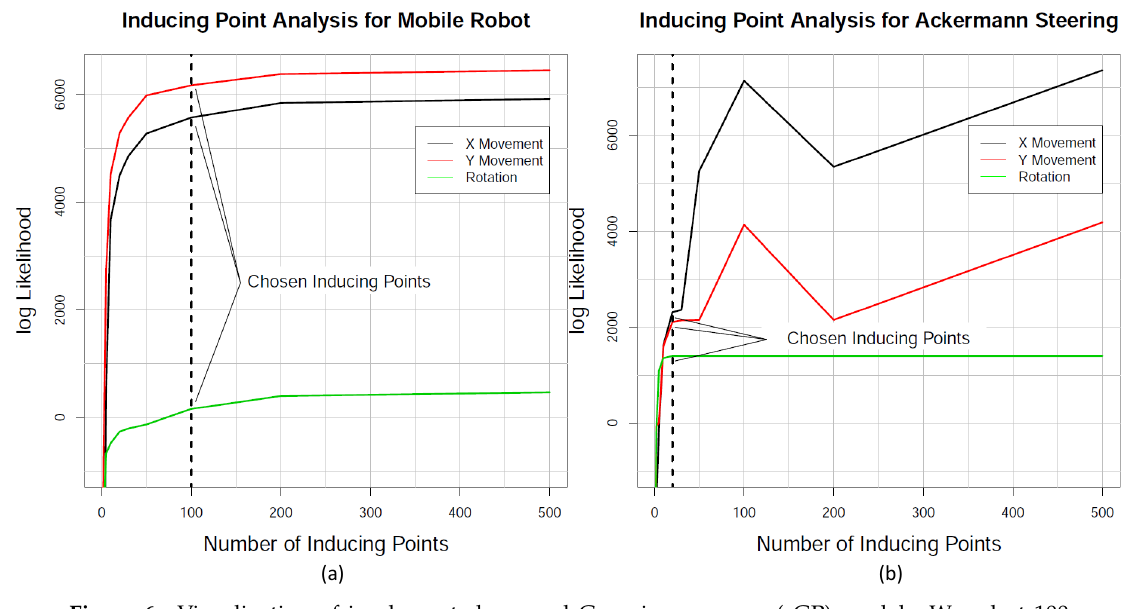
Figure 6. Visualization of implemented sparsed Gaussian processe (sGP) models. We select 100 auxiliary points for the mobile robot ( a ). After analyzing the R 2 value of the Ackermann motion models, we chose 20 auxiliary points for the car simulation ( b ).